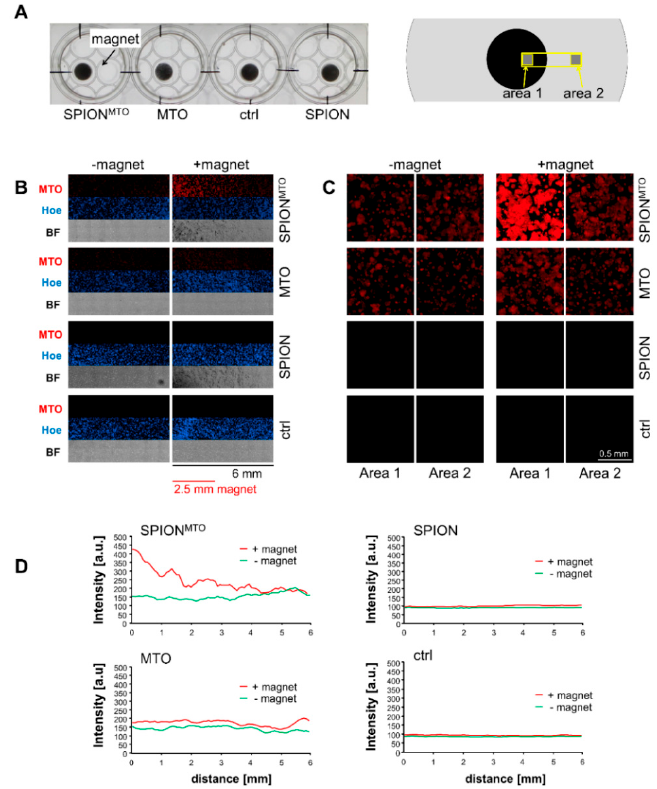
Figure 2. Magnetic accumulation. ( A ) Experimental setup: HT-29 cells seeded into 12-well plates were treated with free MTO, SPION MTO and unloaded SPIONs (MTO concentration 0.25 µ M with corresponding Fe concentration, see Table 2). Magnets (diameter 0.5 cm) were placed under the cell-containing plate and incubated for 5 h. ( B ) Overview pictures. Cells were fixated and stained with Hoechst 33342. 8 × 3 single pictures were taken in fluorescence microscopy and stitched together, resulting in a 6 mm × 1.33 mm large area (see yellow box in ( A ), right scheme). ( C ) Close-up on areas 1 (cells above the magnet) and 2 (cells in distance to the magnet). ( D ) Distribution of MTO fluorescence along the analyzed area was determined with Zen software. BF: Bright field images. The experiment was performed in